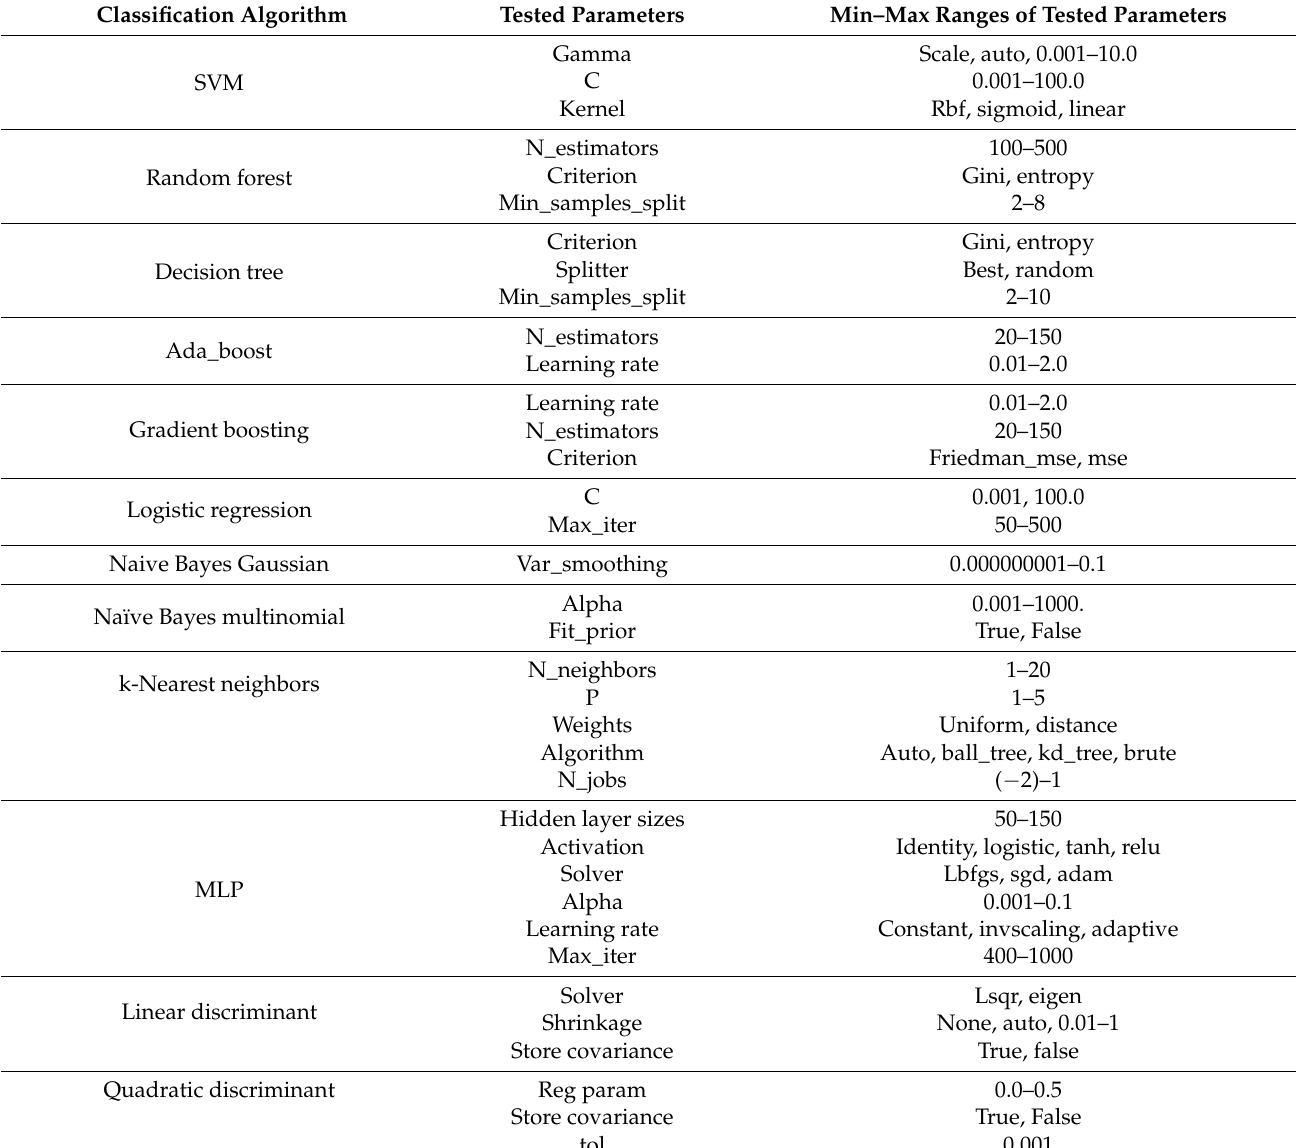
Table 2. List of classification algorithms utilized in the randomized search, along with the related